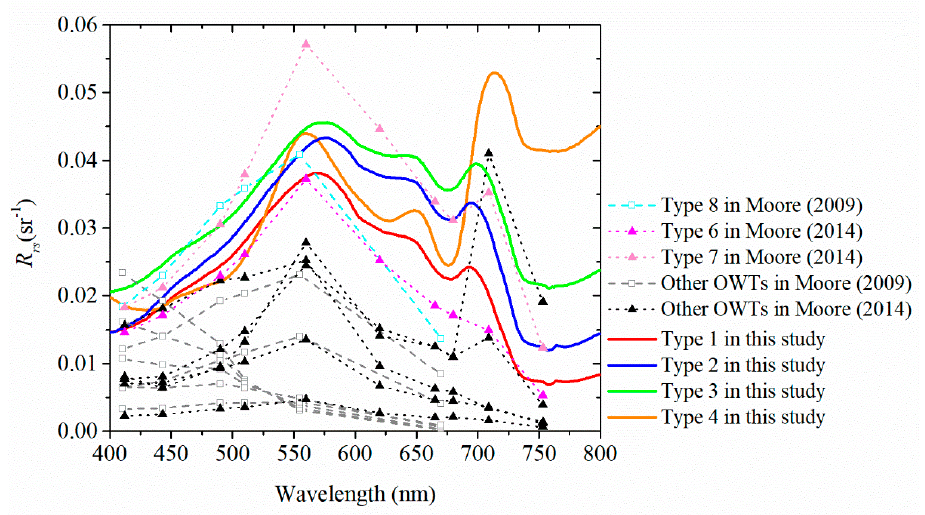
Figure 9. The comparison of mean R rs ( λ ) of the four optical water types with the optical water types in the previous studies [21,23]. The dashed lines represent mean R rs ( λ ) of OWTs acquired from Table A1 in Moore et al. (2009) [21] and Table 2 in Moore et al. (2014) [23].